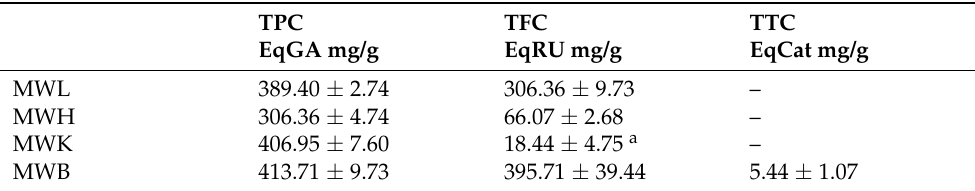
Table 1. Total penolic, flavonoid, and tocopherol contents of Juglans regia methanolic extracts. a p < 0.05, Data expressed as mean ± SD. Abbreviations; GA: Gallic acid; RU: Rutin; Cat: Cate- chin, MWB: Methanolic Extract of bark, MWH: Methanolic extract of Husk, MWK: Methanolic Extract of Kernels, MWL Methanolic Extract of